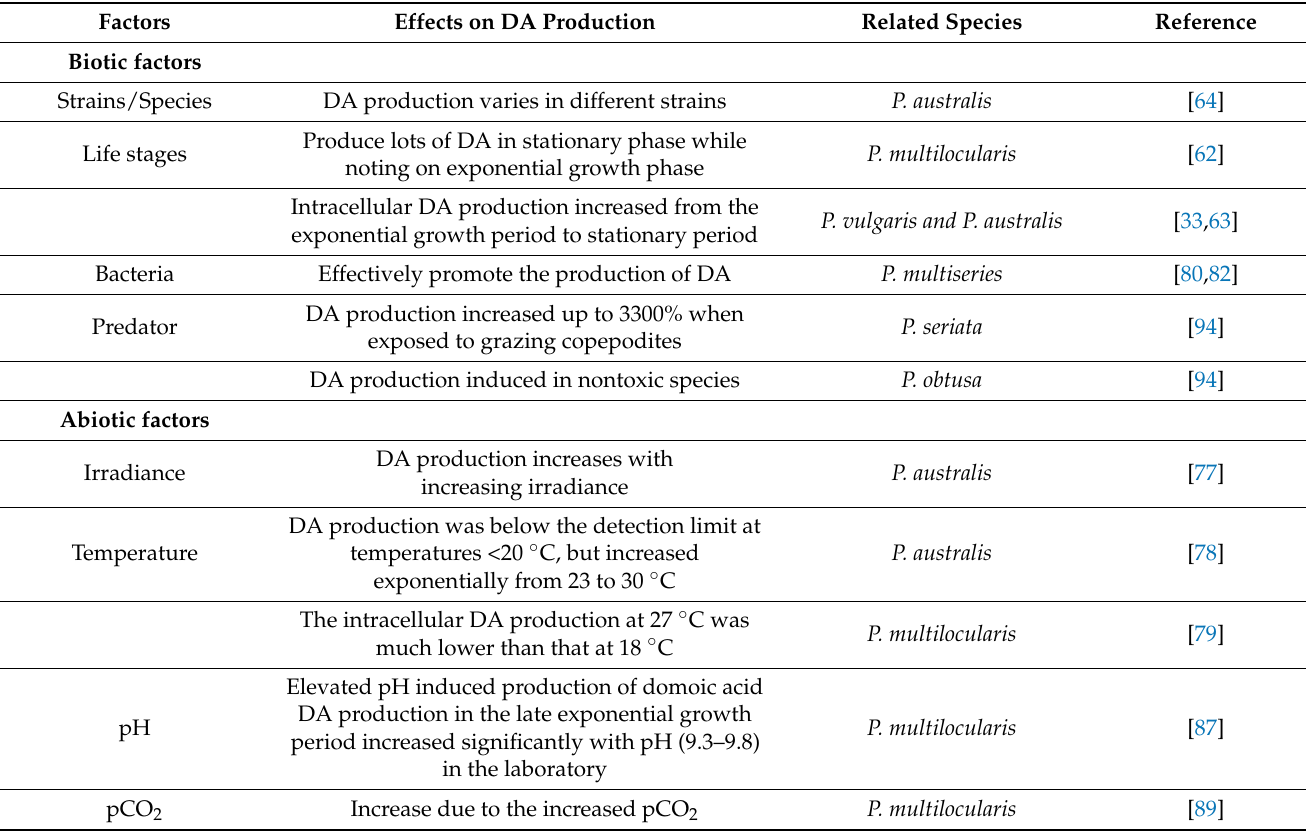
Table 2. Factors affecting the production of domoic acid (DA) by Pseudo-nitzschia